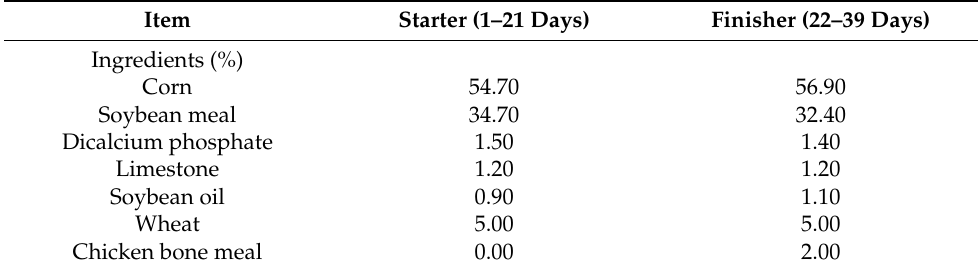
Table 4. Ingredient and nutrient composition of the basal diet (as-fed basis, % unless